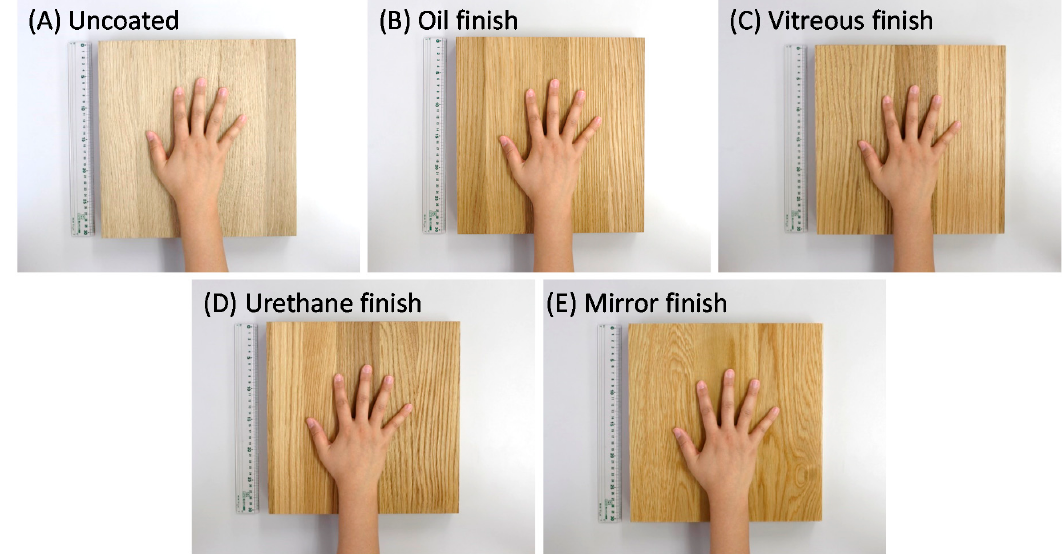
Figure 3. Materials used for the tactile experiment. ( A ) Uncoated wood; ( B ) oil-finished wood; ( C ) vitreous-finished wood; ( D ) urethane-finished wood; ( E ) mirror-finished wood. Table 1. Details of materials. h : thickness of materials; λ : thermal conductivity; Ra : arithmetic average roughness; JCP : Japanese cedar plywood.